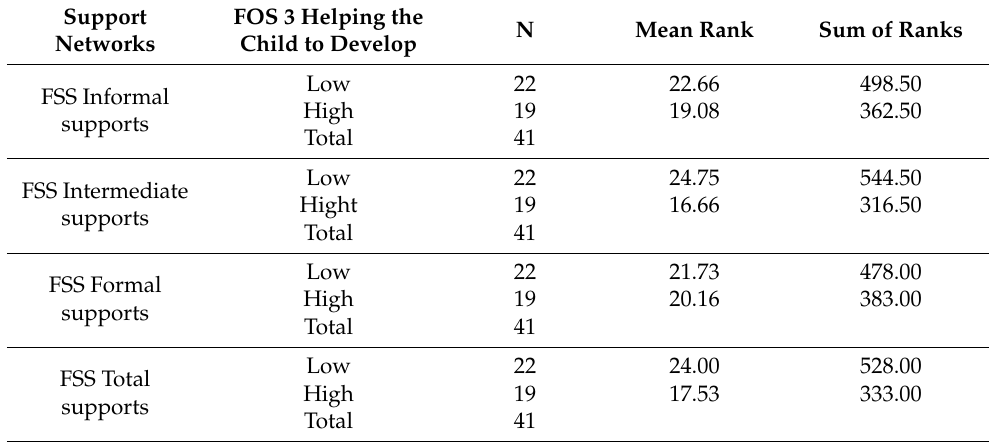
Table 7. Relationship between high and low empowerment and the support network.